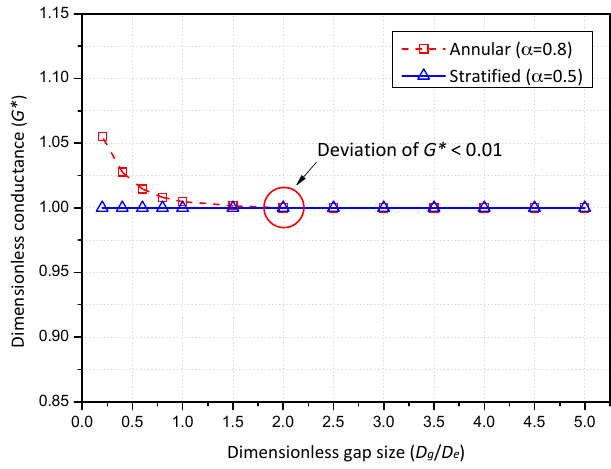
Figure 3. Variation of the calculated conductance according to the spacing between layers.